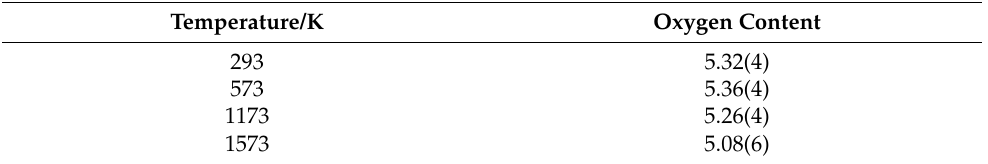
Table 3. Refined oxygen contents during the heating of Ba 2 In 1.8 Cr 0.2 O 5.3 (H 2 O) x in a dynamic vacuum ( p min ≥ 1.2×10 −5 mbar) from room temperature to 1573 K at D20, ILL, Grenoble.